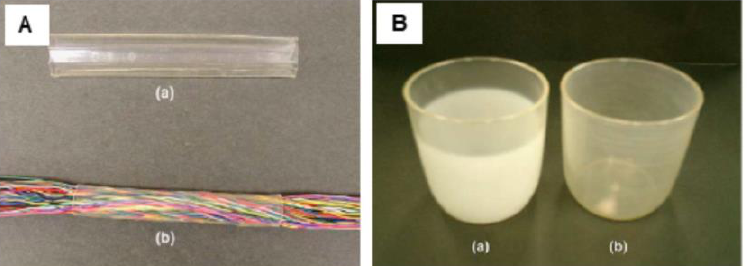
Figure 7. PLLA crosslinked by electron beam irradiation (50 kGy). ( A ) shrinkable tube ( a ); possible use ( b ). ( B ) Appearance of cups after using for hot water: ( a ) the unirradiated product, ( b ) the product crosslinked by irradiation [31]. (Adapted with permission from Elsevier, 2005).